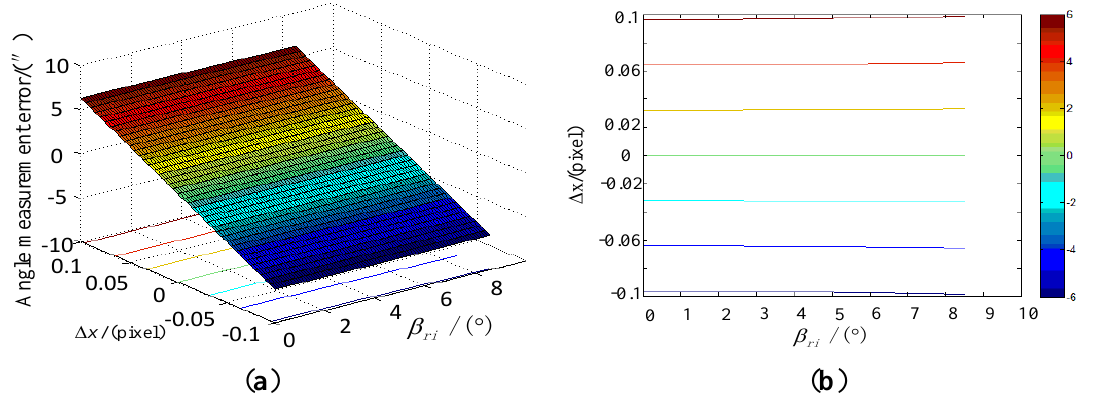
Figure 4. Influence of the star point extraction error on the star tracker accuracy. ( a ) is obtained when the star point extraction error Δ x is among the range from −0.1 pixels to 0.1 pixels; ( b ) is the contour line of (a).